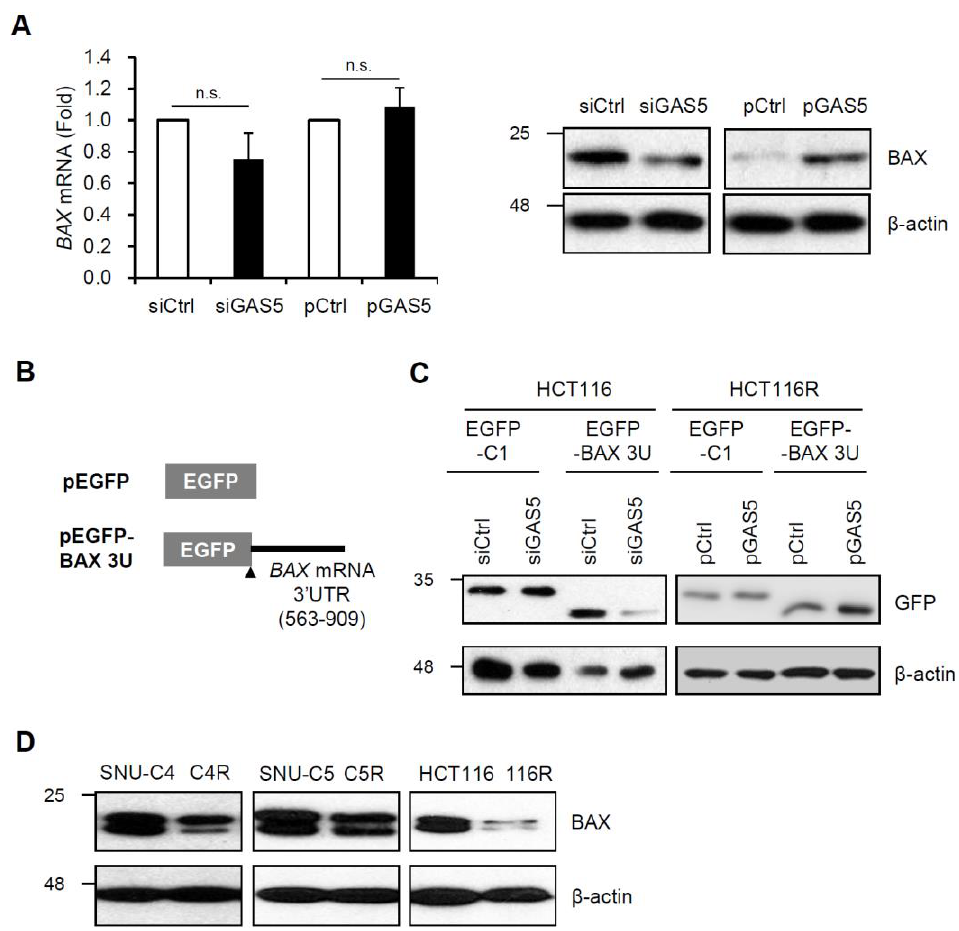
Figure 4. Regulation of BAX expression by GAS5. ( A ) HCT116 cells transfected with siRNAs or plasmids were incubated with 5-FU for 24 h. Relative BAX expression was assessed by RT-qPCR and western blotting analysis. GAPDH mRNA was used for the normalization. β -actin was used as a loading control. ( B , C ) The EGFP reporter assay. ( B ) Schematics of the EGFP reporters. The reporter plasmid containing the 3 (cid:48) UTR of BAX mRNA (pEGFP-BAX 3U) was generated by inserting the 563-909 nt region of BAX mRNA into pEGFP. ( C ) After sequential transfection of siRNAs or plasmids with the EGFP reporters, relative reporter expressions between HCT116 cells and HCT116R cells were determined by western blotting analysis. Data were expressed as mean ± SEM, and images are representative of three independent experiments. ( D ) Relative BAX expressions between 5-FU resistant cells and their parental cells were assessed by western blotting analysis. β -actin was used as a loading control. Images are representative of three independent experiments. The statistical significance of the data was analyzed via Student’s t -test; n.s., not significant.